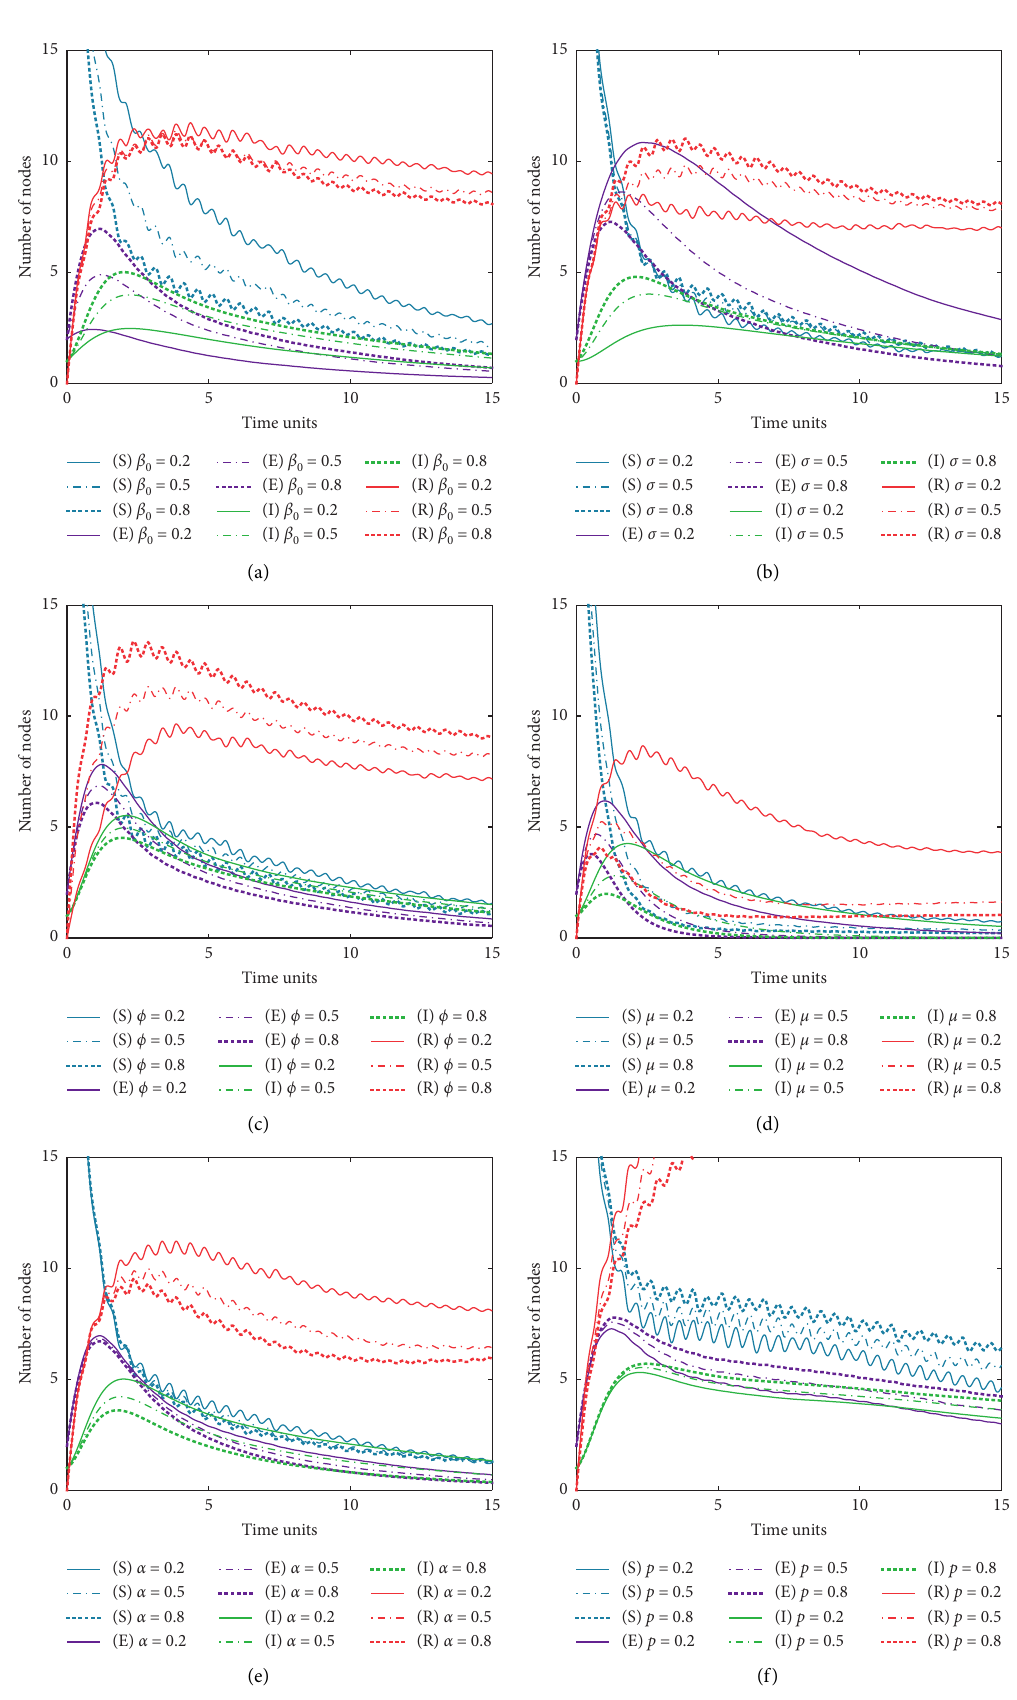
used in the infection 0